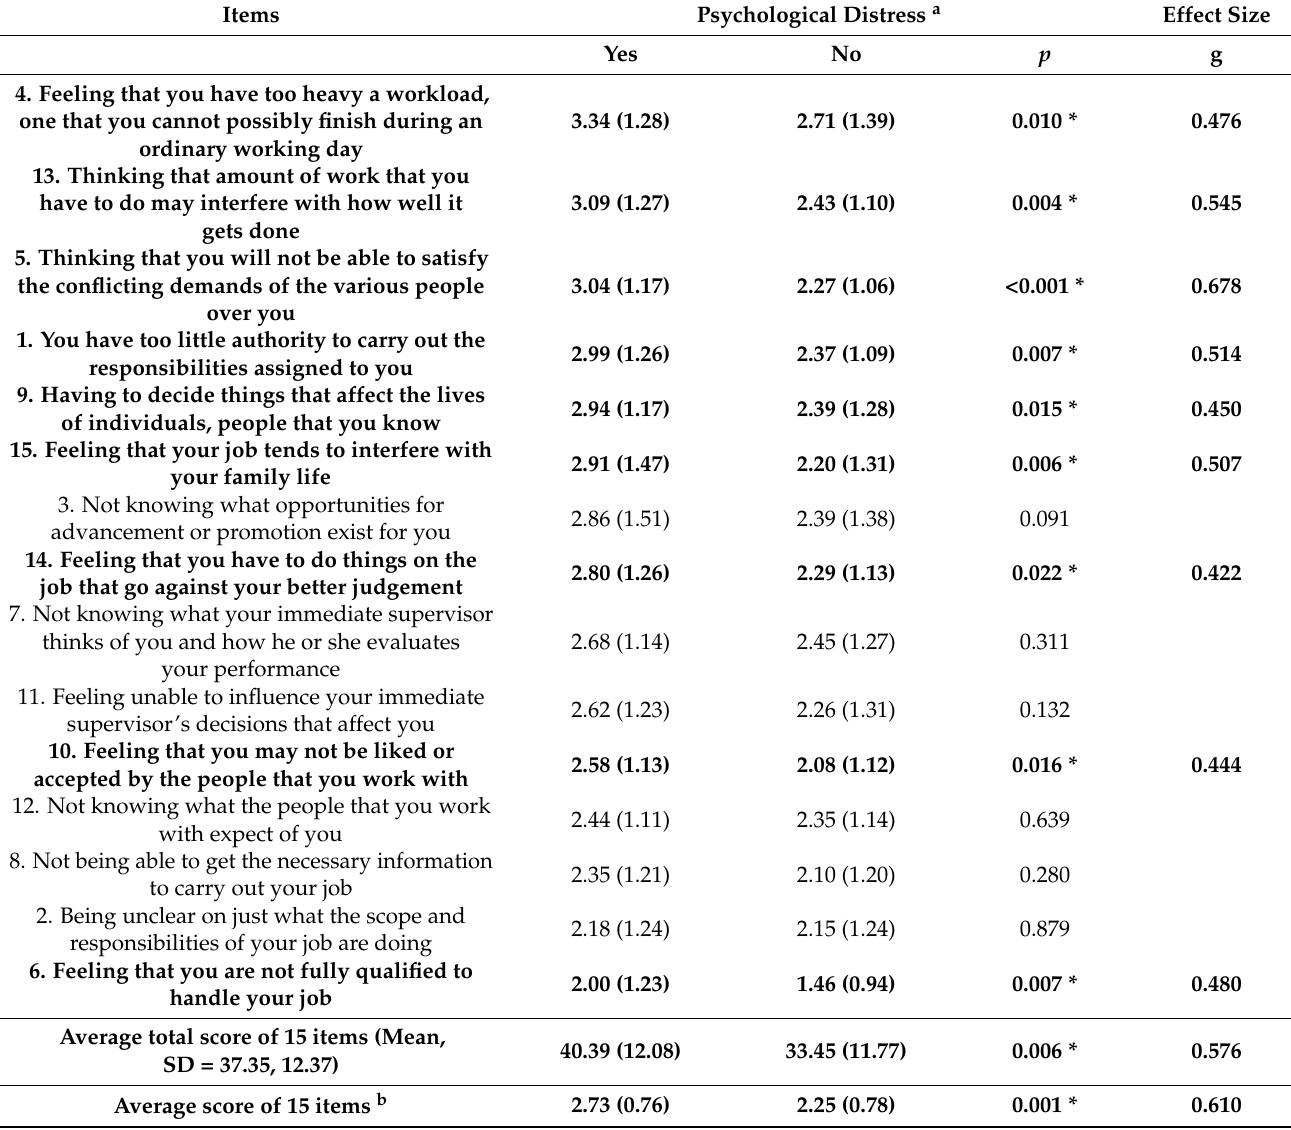
Table 3. Association between Job-Related Tension Index and psychological